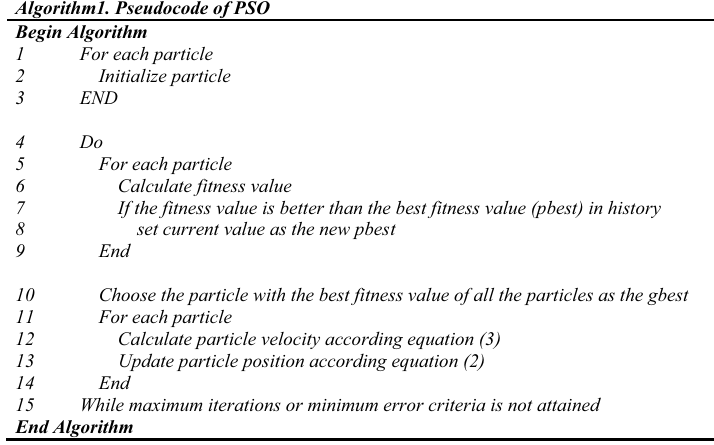
Algorithm 1. The pseudocode of PSO algorithm Algorithm1. Pseudocode of PSO Begin